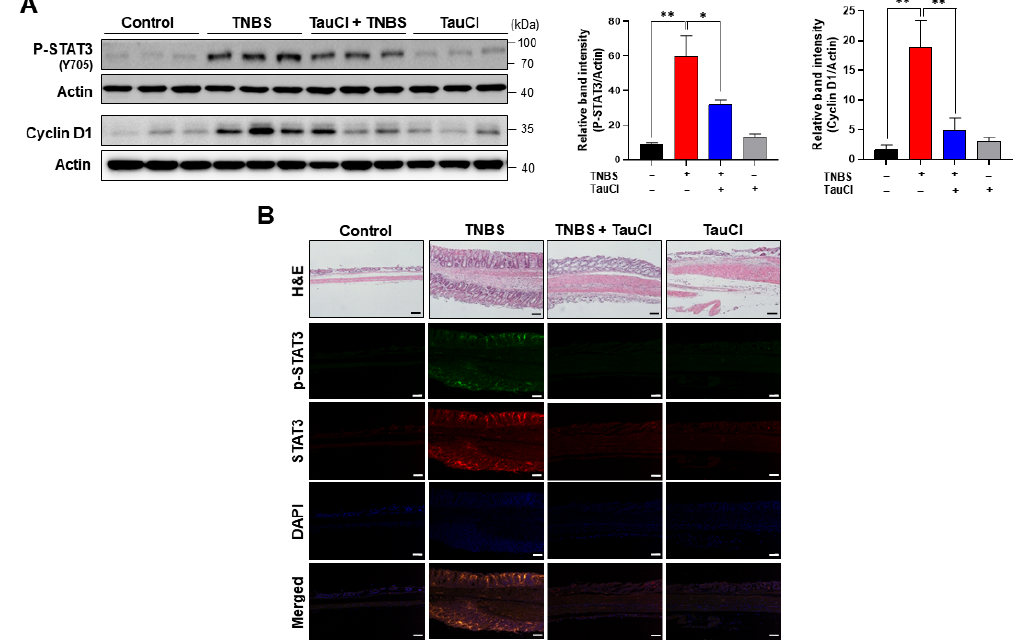
Figure 5. Inhibitory effects of TauCl on phosphorylation of STAT3 and its target protein expression in the colonic tissue of TNBS-treated mice. ( A ) Expression of P-STAT3 and cyclin D1 was measured by Western blot analysis. Actin was used as an equal loading control. * , ** Significantly different between groups compared (* p < 0.05; ** p < 0.01). ( B ) Phosphorylated as well as total STAT3 was detected by immunofluorescence staining. The same tissue sections were stained with H&E. Scale bar, 200 μ m.